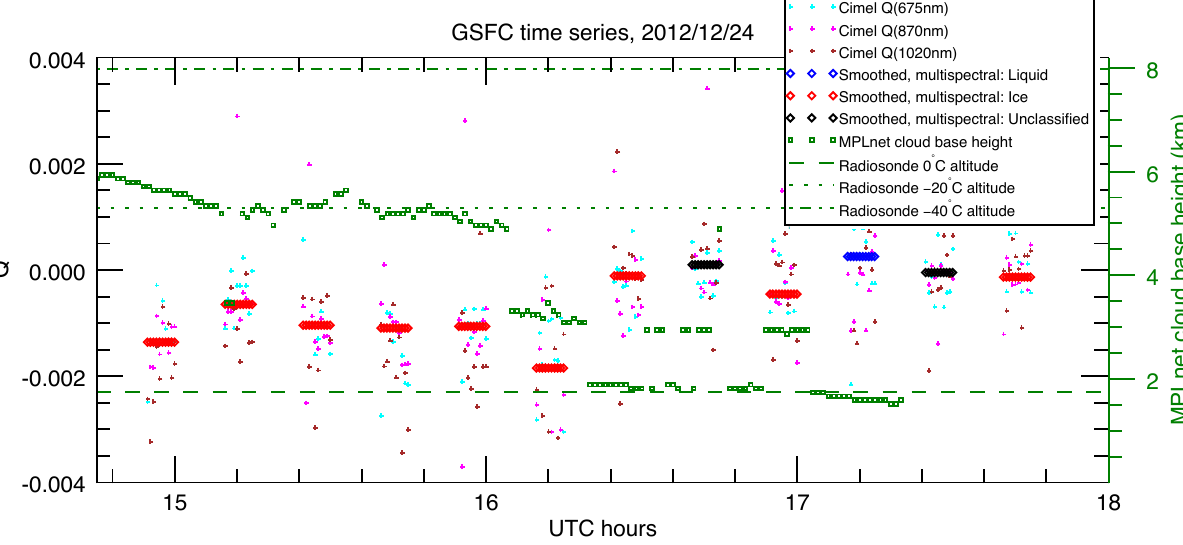
Figure 13. Cimel polarized radiance and MPLNET cloud base height from 24 December 2012 at the NASA GSFC site. Local noon was at 17:00UTC. Lidar cloud base heights (green) indicate high-altitude clouds before roughly 16:00, followed by low-altitude clouds. Cimel nadir observations of Q at 675nm (cyan), 870nm (magenta), and 1020nm (brown) show a high degree of scatter but generally more negative values during high-altitude cloud cover. A radiosonde launched at Sterling, Virginia (Washington Dulles International Airport), roughly 50km west of NASA GSFC, found temperatures of 0 ◦ C at 1750m, − 20 ◦ C at 5.3km and − 40 ◦ C at roughly 8km, indicating that the lowest clouds were almost certainly comprised of liquid droplets, while the higher clouds were probably comprised of ice particles. A multispectral smoothed product, representing the median of a moving window of data from all three channels taken within 8min of the window center, is shown as diamonds. These data are classified in the same way as were the CESAR data, where values less than − 0.0001 are identified as ice (red), larger than 0.0001 as liquid (blue), and unclassified (black) between those